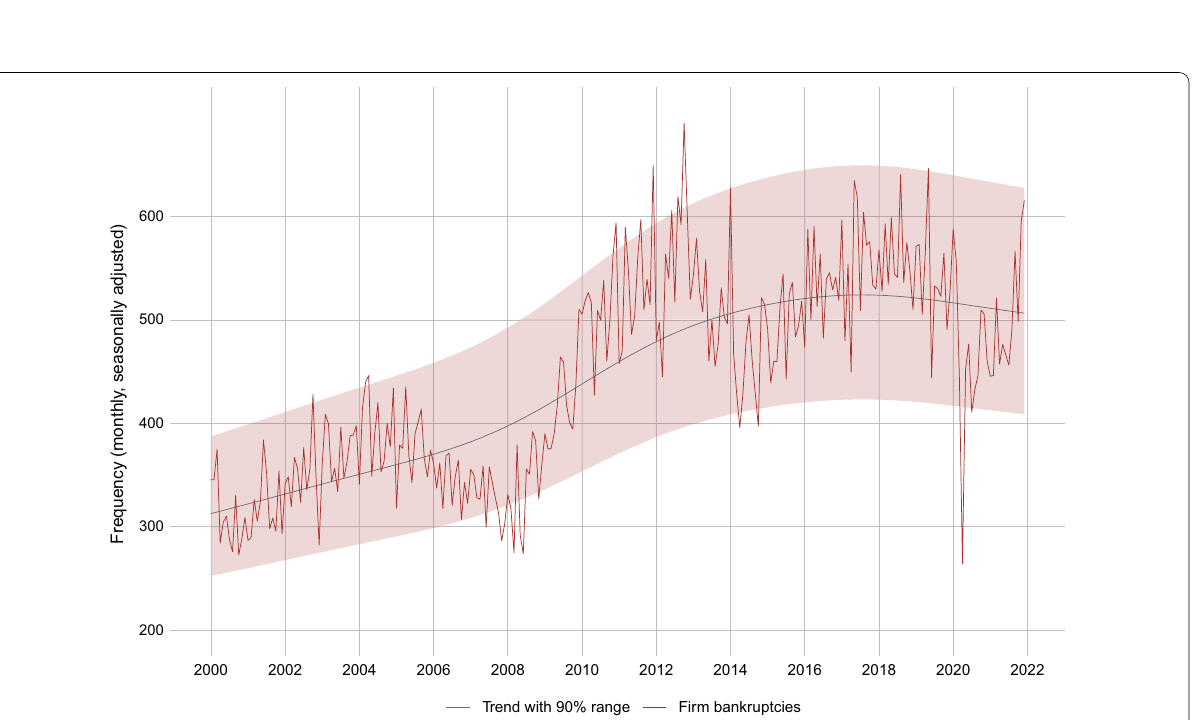
Fig. 15 Firm bankruptcies in Switzerland Including SCO Art. 731b Cases. Notes : The figure shows the monthly seasonally adjusted frequency of total firm bankrupcties in Switzerland including SCO Art. 731b cases, together with a trend and the 90% probability range. Note that most of the trend increase from 2008 to 2012 was due to a law change which stipulated the counting of SCO Art. 731b cases as